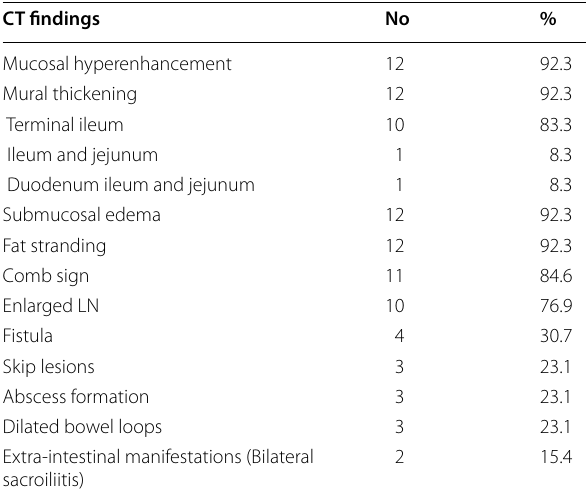
Table 1 Distribution of the studied cases according to CT findings for acute exacerbation of inflammatory bowel diseases (Crohn’s) ( n 13) =